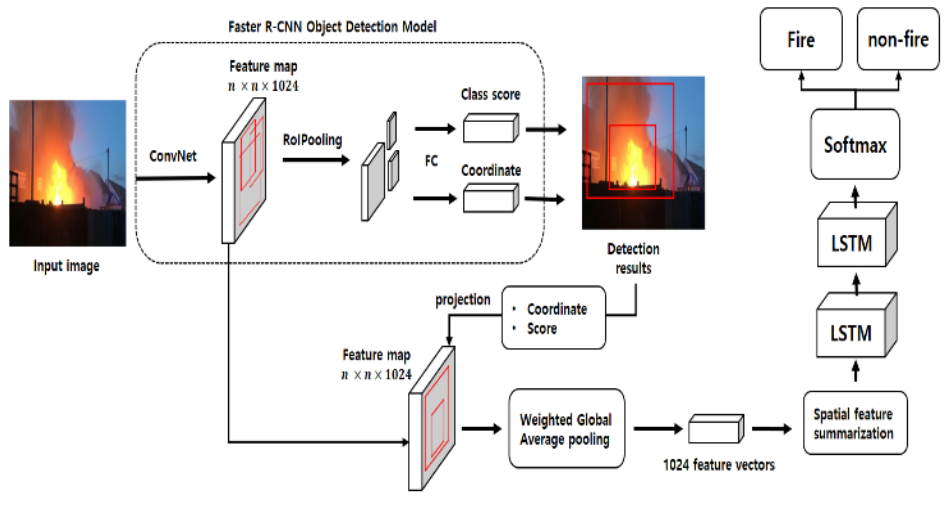
Figure 6. The LSTM network for fire decision [26].